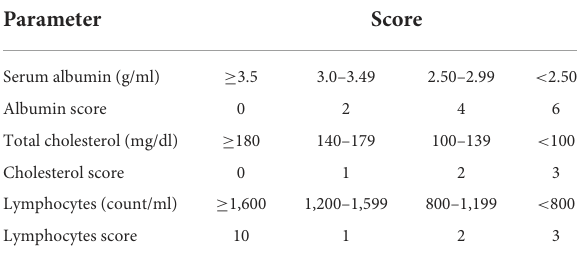
TABLE 1 Parameters for assessment of the CONUT